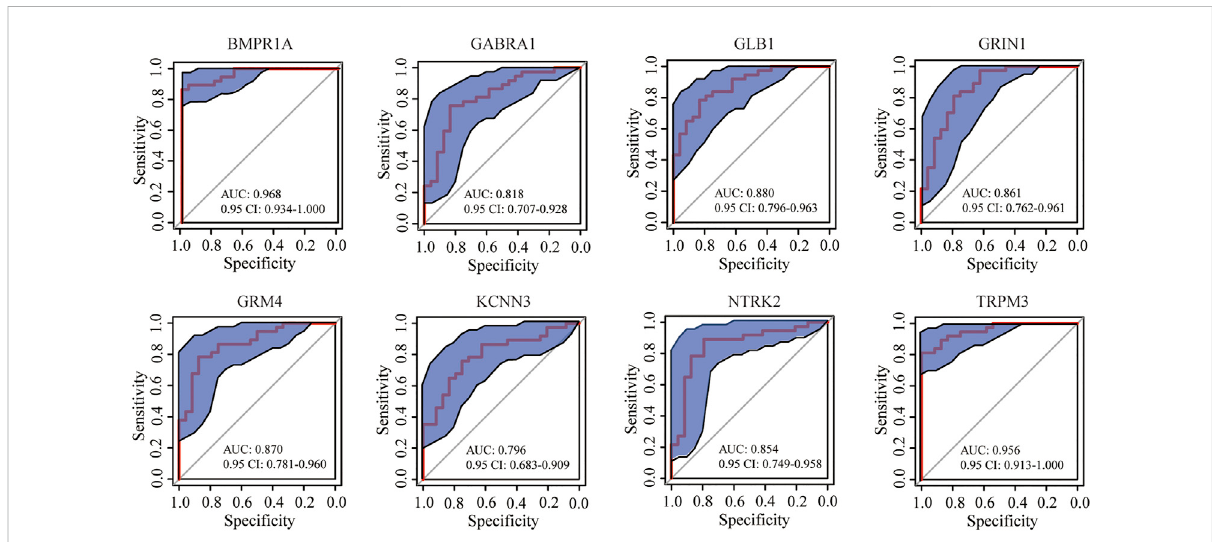
FIGURE 8 ROCcurveofeightgenesinpredictingADsamples:bluearearepresentsthe0.95CIvalueofeachgeneforthepredictionofAD;redcurveisthe ROC curve of eight genes in predicting AD; almost all AUCs of the gene were higher than 0.8, and the AUCs for BMPR1A and TRPM3 were higher than 0.95.